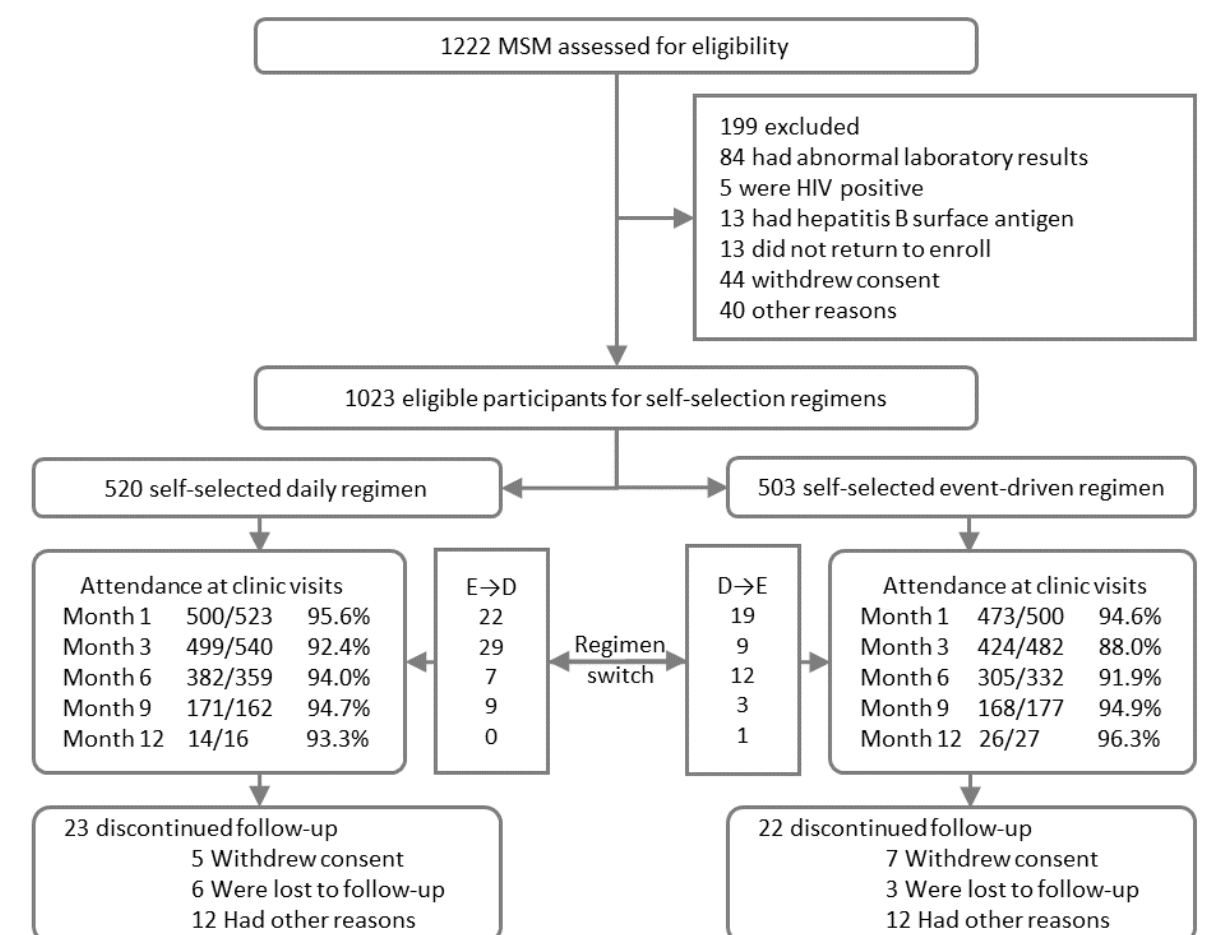
Figure 1. Enrollment and follow up of the study participants. D → E: switching from daily to event-driven regimen; E → D: switching from event-driven to daily regimen; MSM: men who have sex with